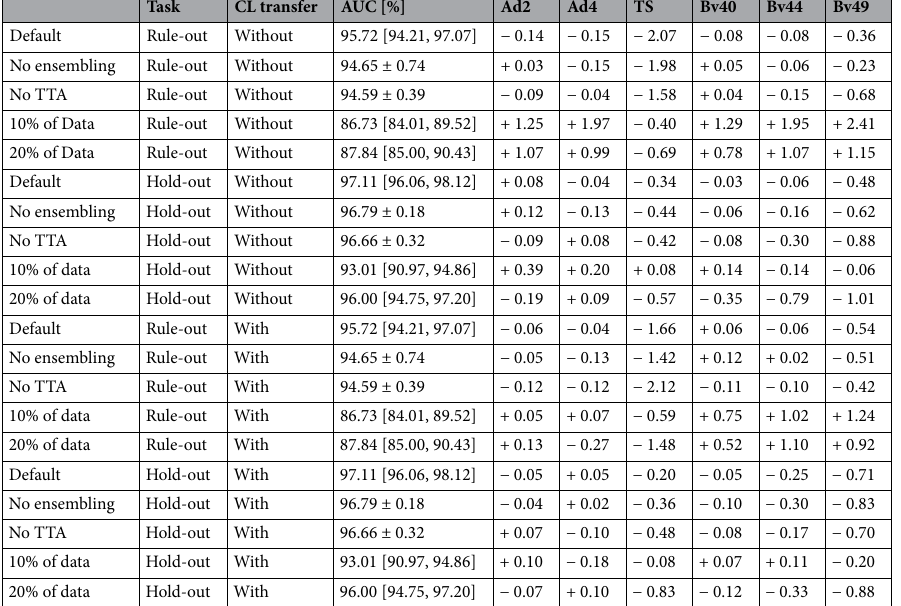
Table 2. Performance deviation for all individual variations (abbreviations as in Fig. 3) compared to the default. “CL Transfer” refers to the centerlines being propagated from the default to the varied configurations. AUC is either displayed with 95 % CI or the standard deviation over all respective single models or